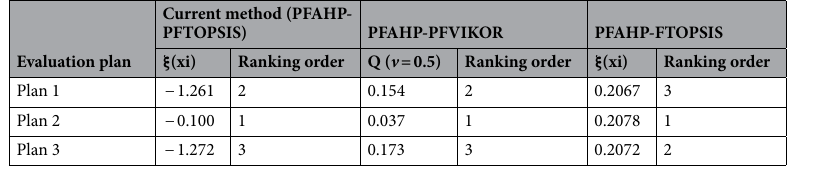
Table 15. Calculation results of each